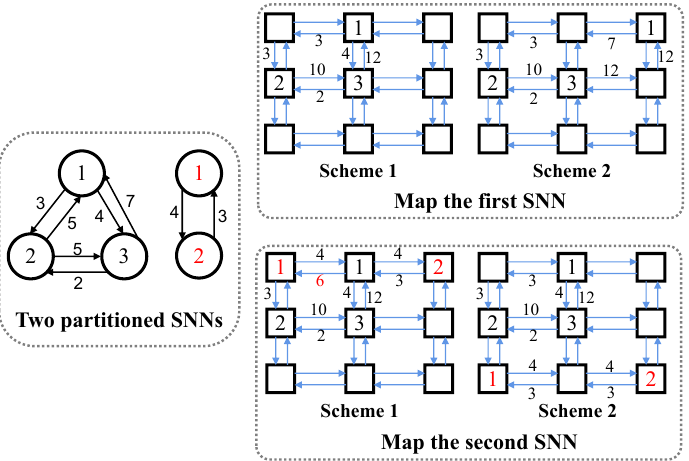
Figure 6. Different mapping schemes for two